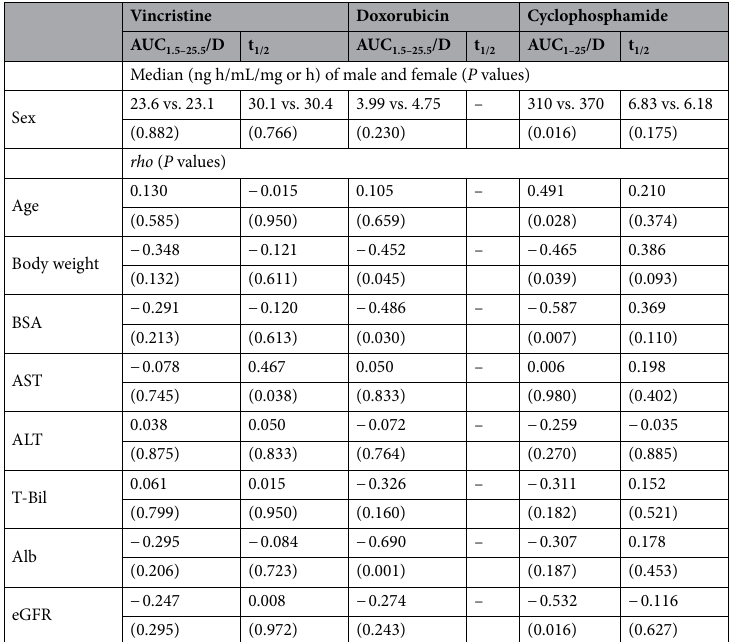
Table 3. Correlations of dose-adjusted AUC and t 1/2 with patient variables. Sex (male:female), 9:11. Alb, serum albumin; ALT, alanine aminotransferase; AST, aspartate aminotransferase; AUC n1–n2 /D, dose-adjusted